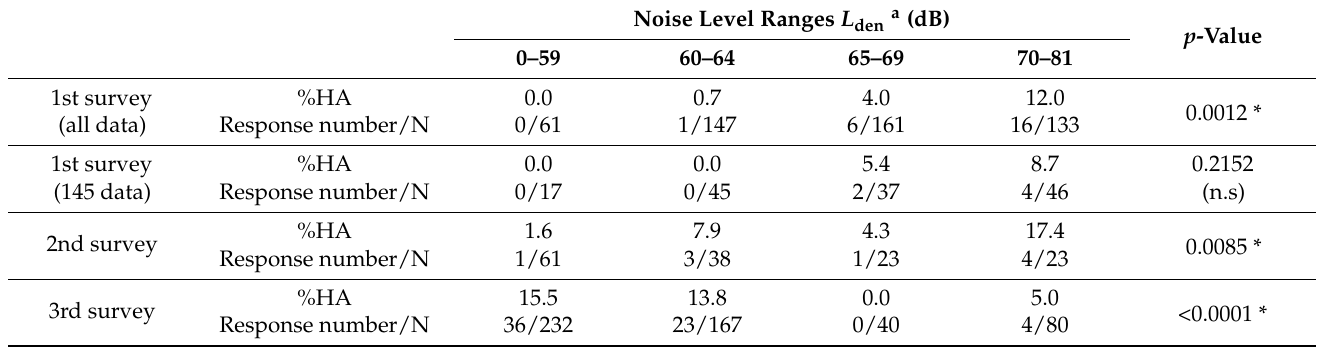
Table 7. Comparison of the percentages of highly annoyed respondents (%HA) across different noise level ranges.